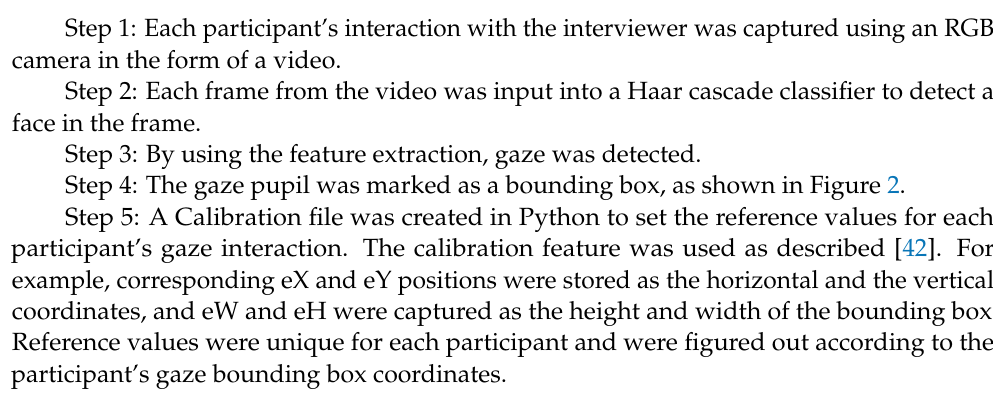
Figure 1. Process of gaze detection with the developed